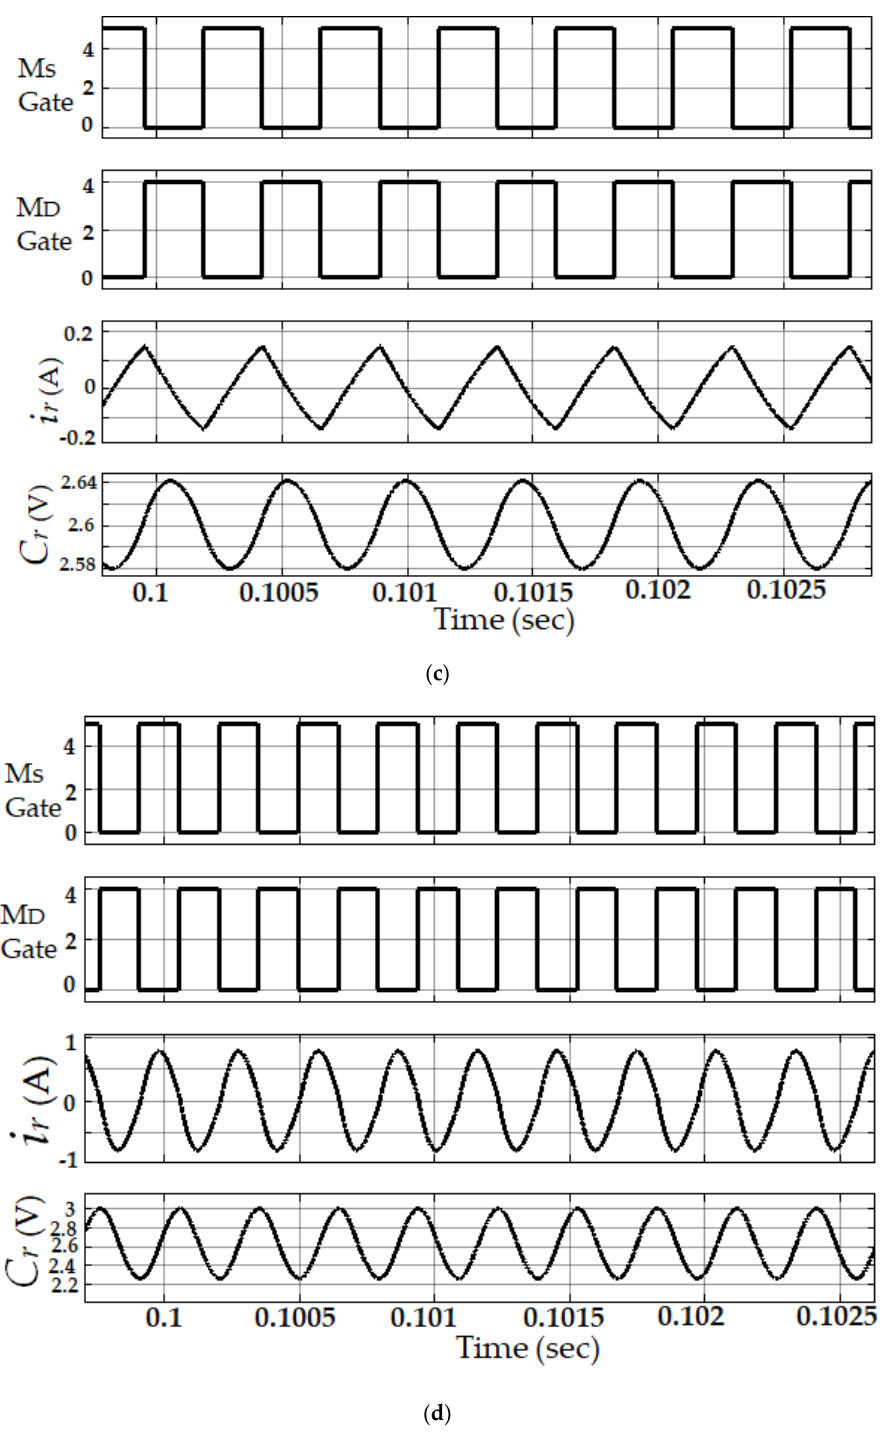
Figure 7. Simulation waveforms with an internal resistor, ( a ) fs = fr , ( b ) fs = 0.5 fr , ( c ) fs = 2 fr . ( d ) Smaller inductor and capacitor.